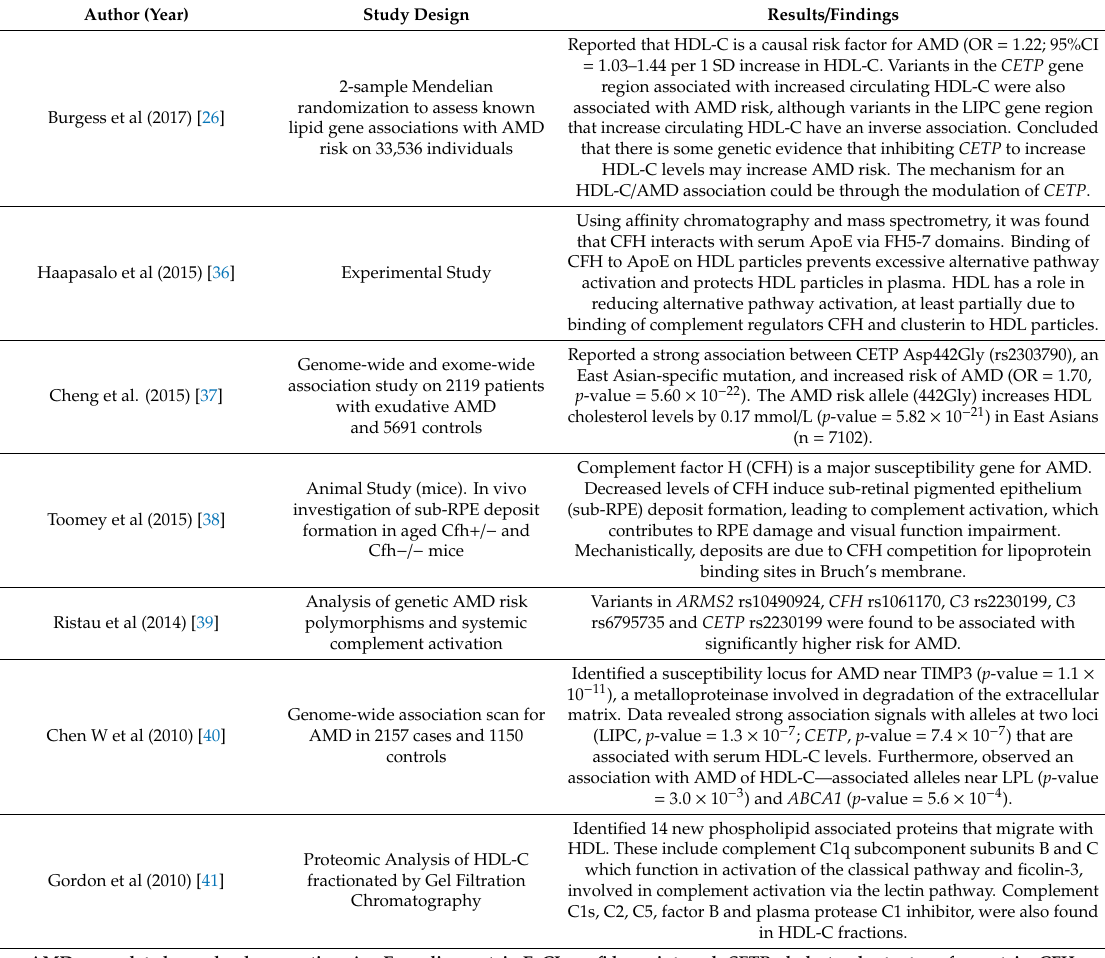
Table 2. HDL-C and AMD—Laboratory Evidence Regarding Possible Pathological Mechanisms (Selected